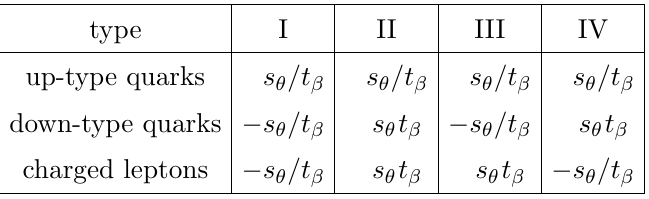
Table 1 . Ratios (cid:24) M of the Yukawa couplings of the pseudoscalar a relative to those of the SM f Higgs in the four types of 2HDM+S models without tree-level